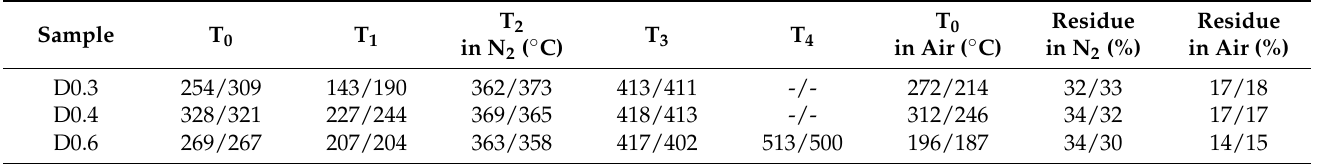
Figure 4. TG and DTG curves of epoxy – silica hybrids prepared with different DETA/DGEBA ratios in ( a ) nitrogen atmosphere, ( b ) air atmosphere, and ( c ) thermal decomposition mechanism of the hybrid structure in a nitrogen atmosphere, where R represents the bond with the DGEBA epoxy resin. Table 4. Characteristic events and parameters of thermal degradation of epoxy–silica hybrids, measured in duplicate (see text).